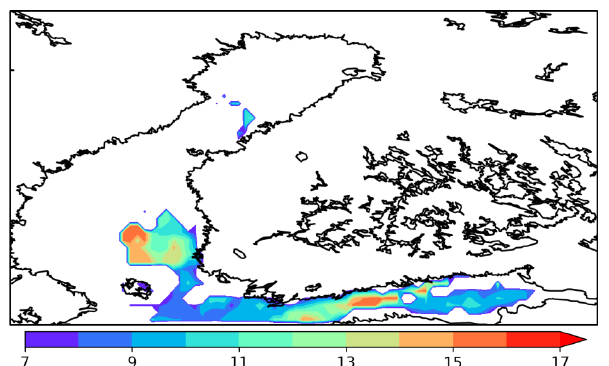
Figure A2. The mean 10m wind speed (ms − 1 ) within the detected snow bands in the Baltic Sea area during 2000–2010 based on RCA4 data.